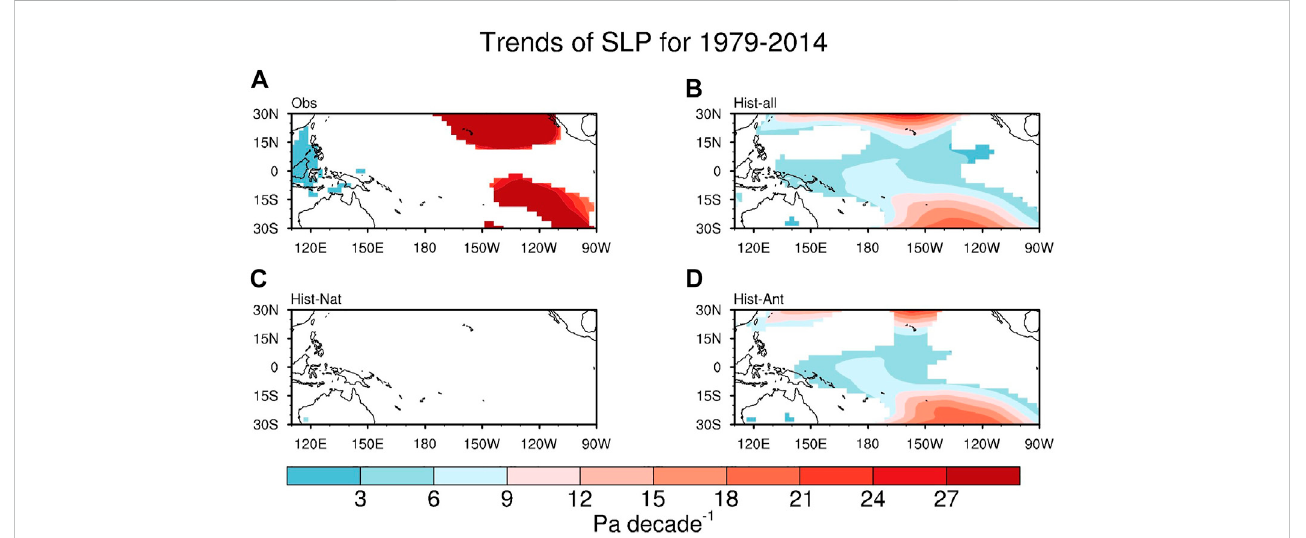
FIGURE 10 Spatial distribution of winter SLP trends (shading, SI = 3 Pa decade − 1 ) from 1979 to 2014 in (A) ERA5, (B) Hist-all, (C) Hist-Nat, and (D) Hist-Ant MME, respectively. Values exceeding the 90% con fi dence levels based on the two-tailed Student ’ s t -test are